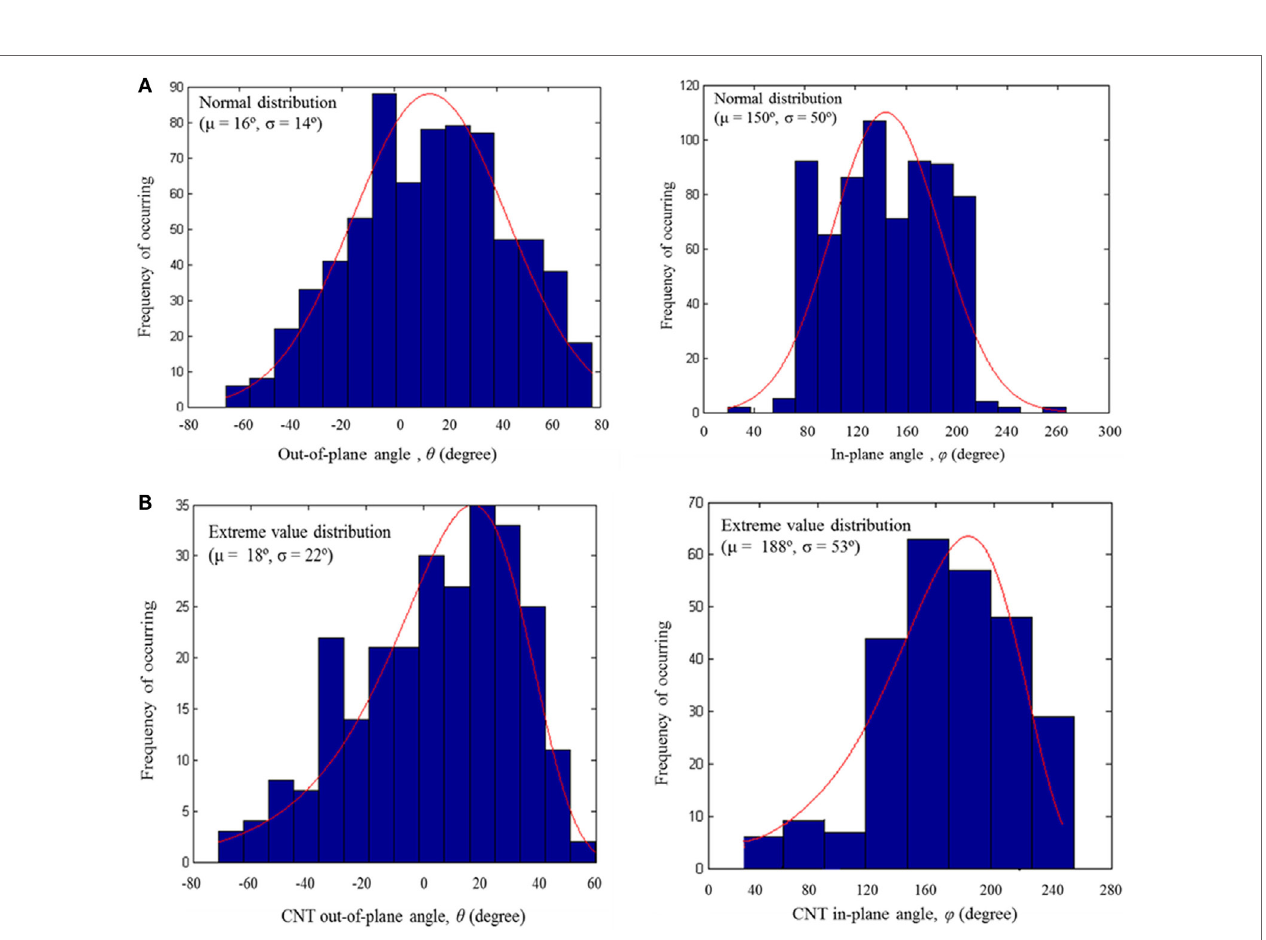
FigUre 8 | cnT orientation distribution within the PP matrix obtained through seM image analysis: (a) bulk and (B) fiber